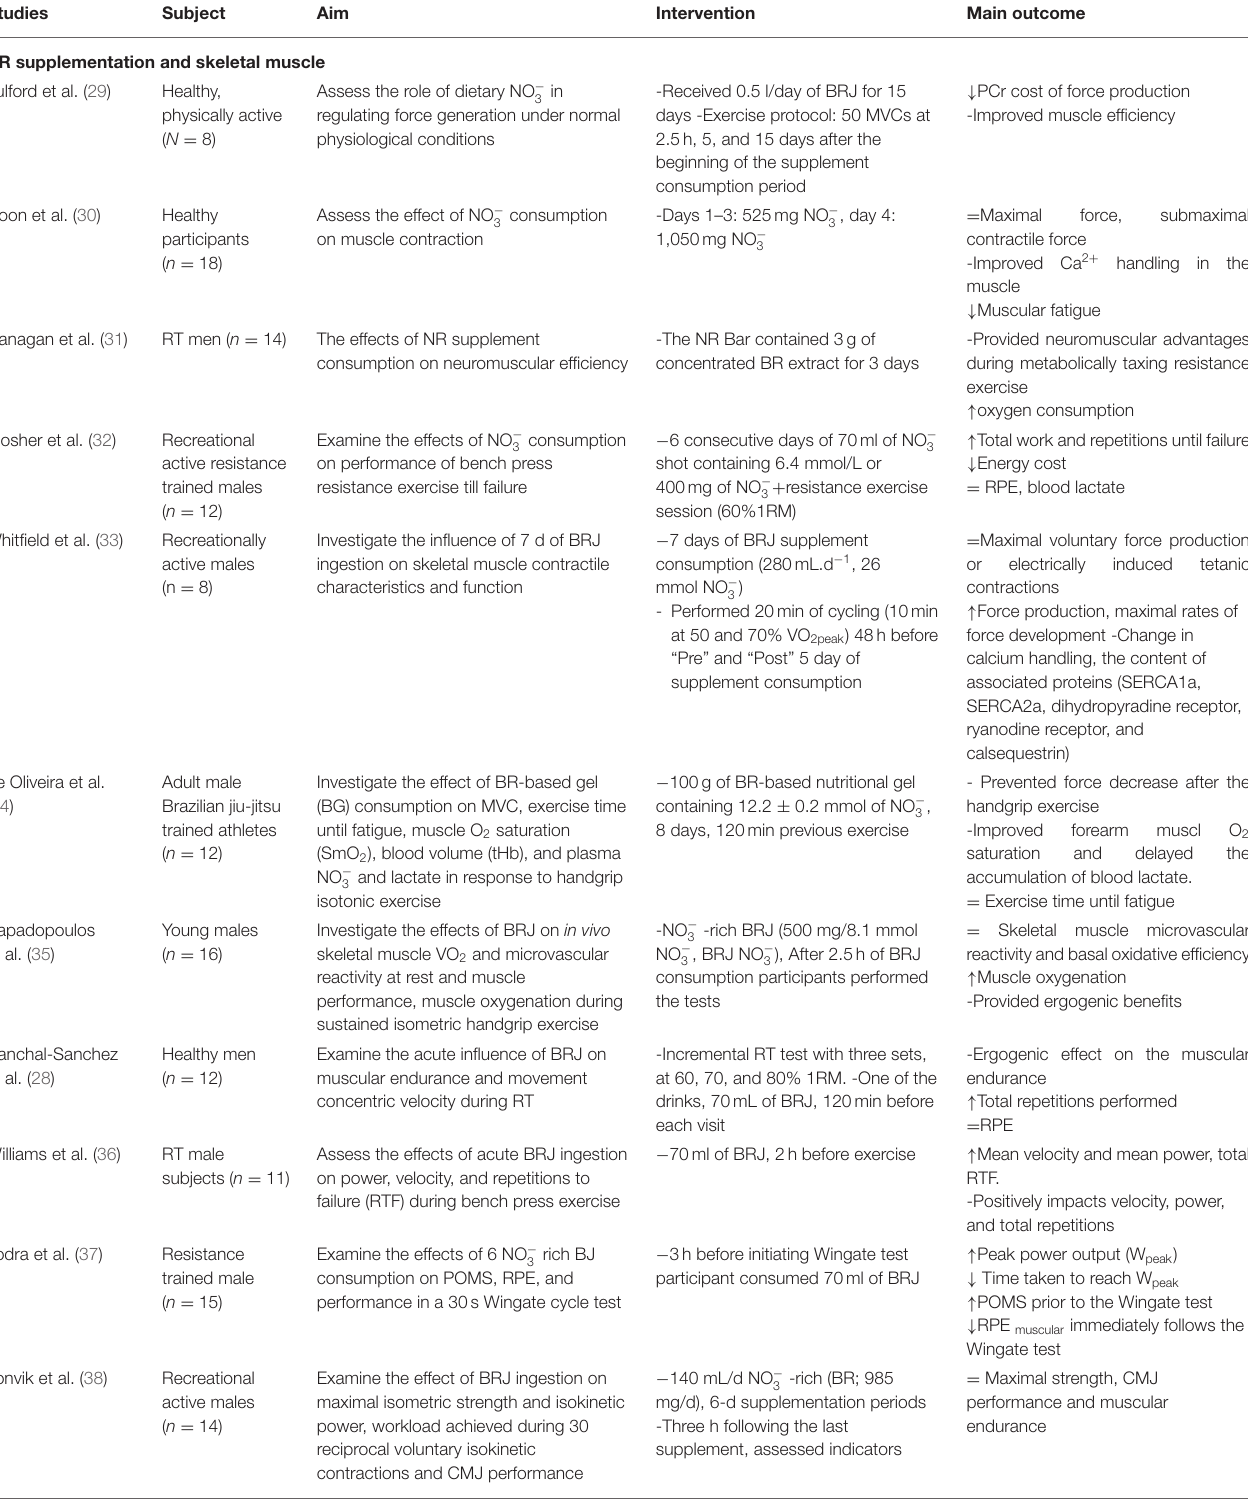
TABLE 2 | Summary of studies investigating the effects of Beetroot supplementation on skeletal muscle, hormonal response, nervous function, O 2 Cost, mitochondria, and oxidative stress.